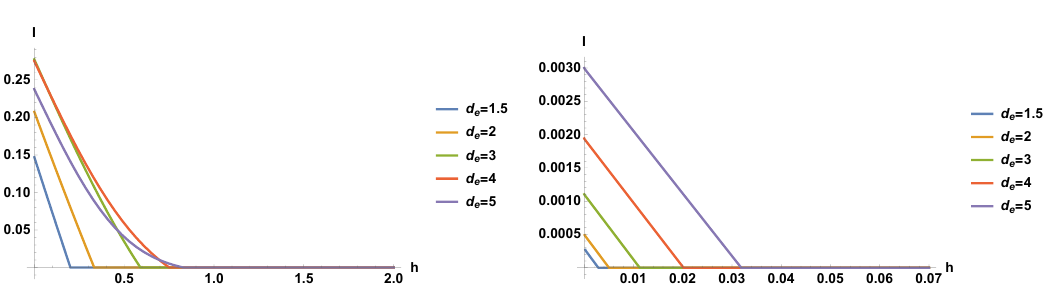
˜ de − 1 , where a = R d L d − 1 . I = r c I a 2 G N r θ F